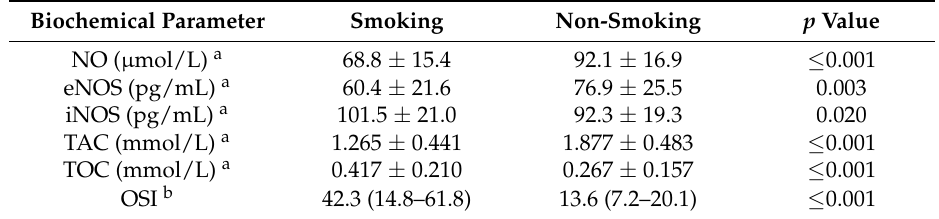
Table 2. Serum concentration of biochemical parameters in the subgroups of smoking (n = 42) and non-smoking pregnant women (n = 57).